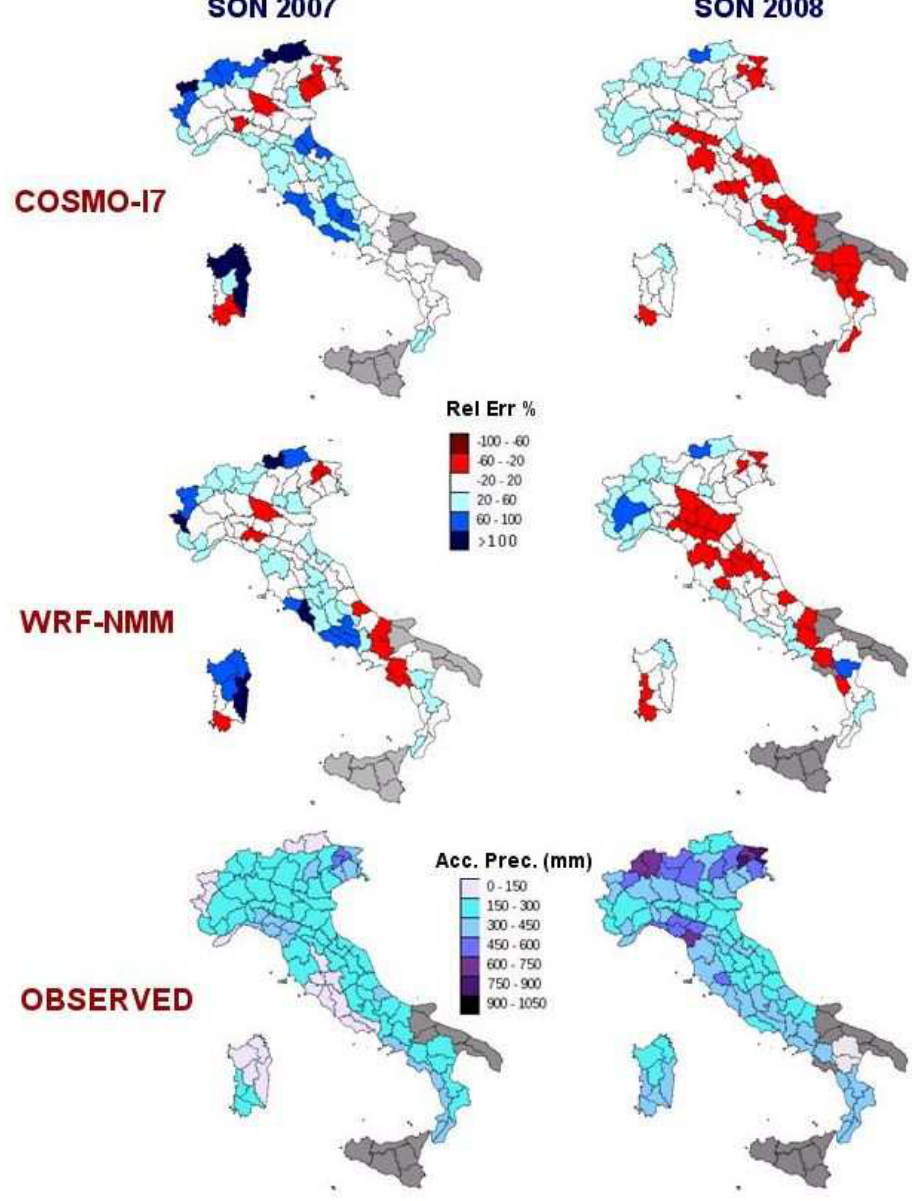
Figure 13. Model error maps (first two rows) and corresponding observed rainfall (bottom row) for autumn 2007 (left column) and 2008 (right column). First row: COSMO-I7 relative errors. Second row: WRF relative errors. For relative error maps red colours means model underestimation, blue colour model overestimation.